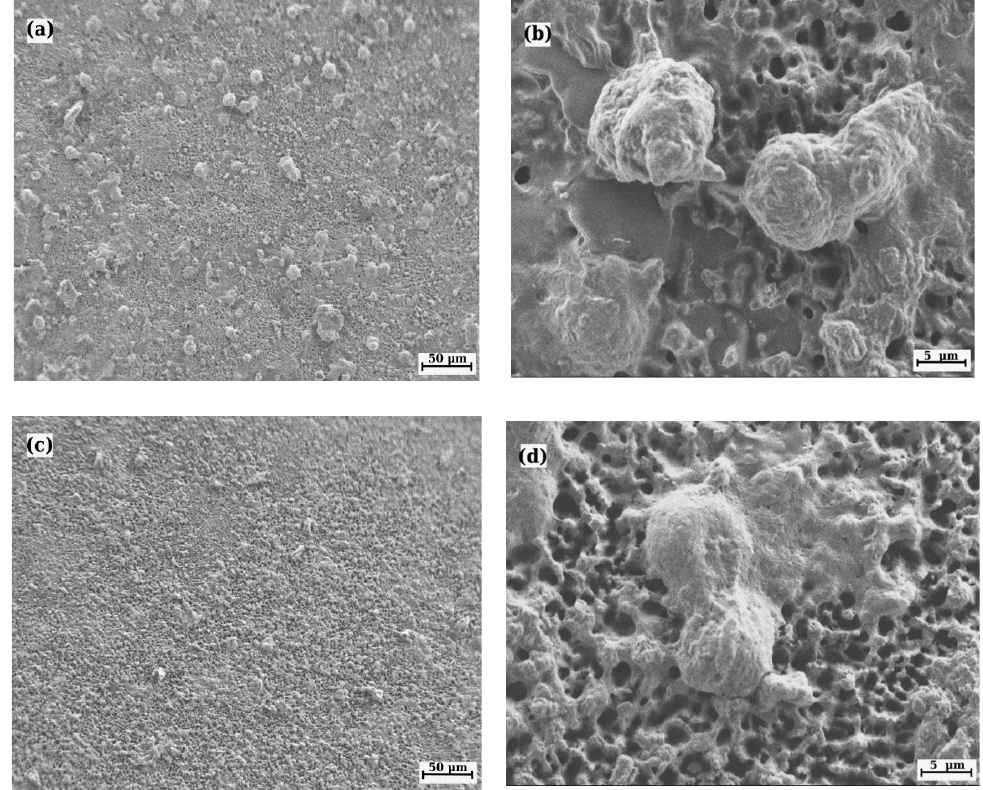
Figure 12. SEM images of osteoblast hFOB for the sample anodized for 60 min after three days ( a , b ) and after 14 days of culture ( c , d ).